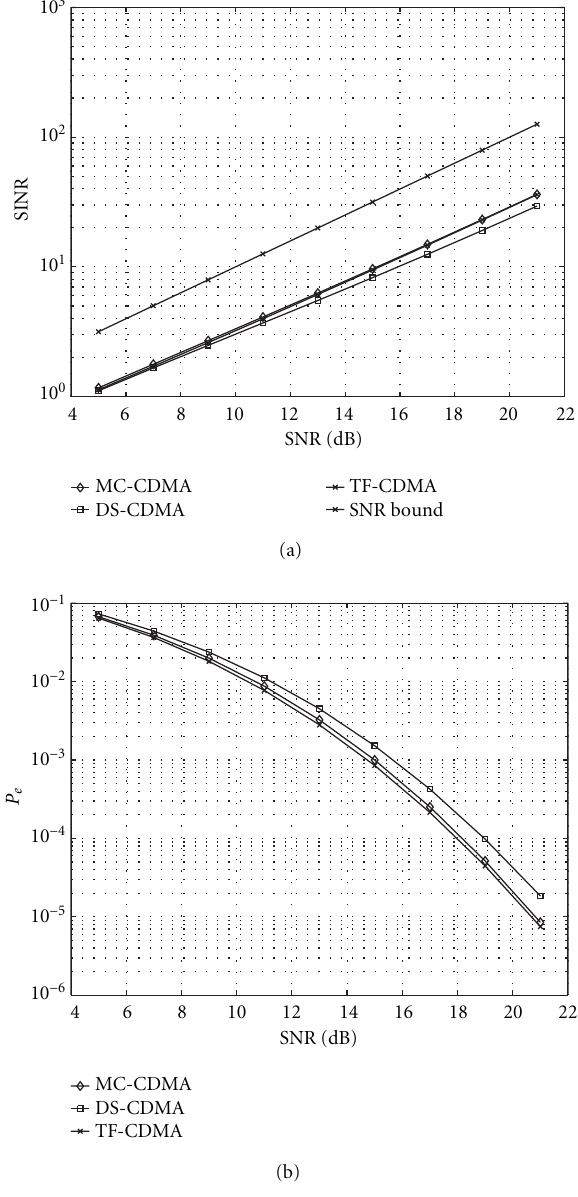
Figure 8: The performance of MC-CDMA, DS-CDMA, and TF- CDMA (MC-DS-CDMA) systems over a TFS channel ( B d T = 0 . 2) for K = 20 users as a function of SNR. (a) SINR. (b) P e